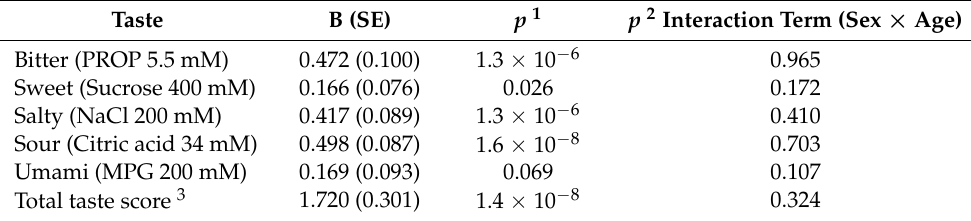
Table 4. Association between sex and taste perception in the whole population.